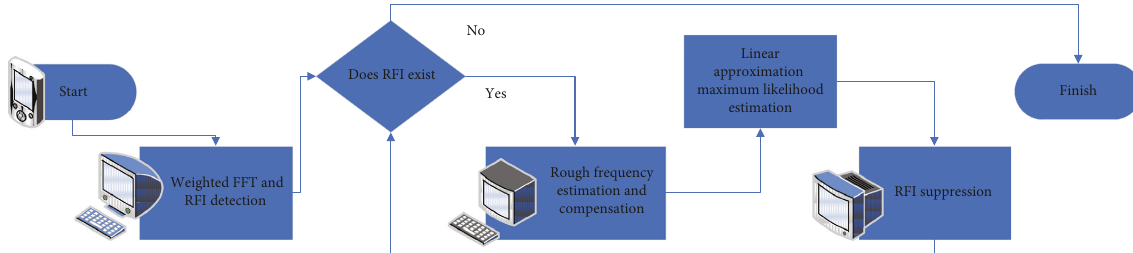
Figure 5: RFI suppression algorithm flowchart.